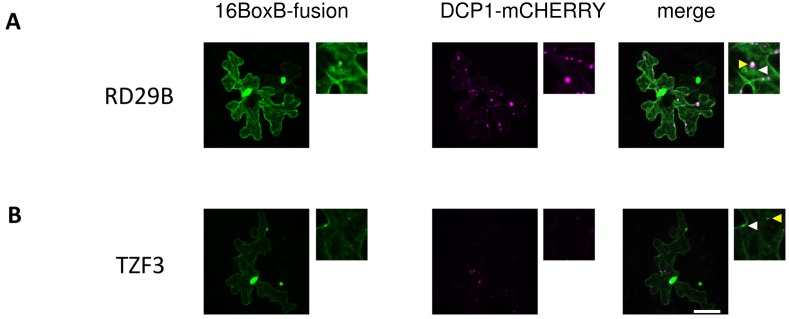
mRNAs of RD29B and TZF3 form cytoplasmic granules.16BoxB-gRD29B (A) and 16BoxB-gTZF3 (B) are indirectly visualized by the LambdaN22-VENUS reporter in transiently transfected leaf epidermis cells (related to Tables 3 and 4). Column I presents the LambdaN22-mVENUS reporter, column II DCP1-mCHERRY, column III the overlay of column I (green) and II (magenta). Rectangular image magnifications present P-bodies nonoverlapping (white arrowheads) and P-bodies overlapping (yellow arrowheads) RNA accumulations. Scale bar: 25 μm.